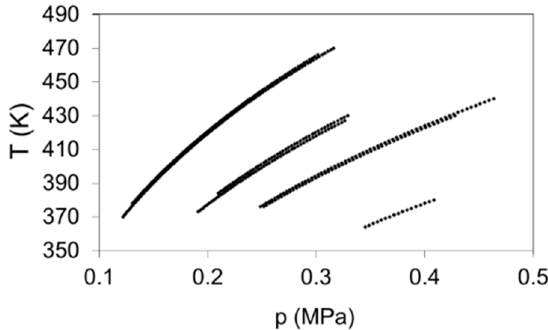
Figure 2. Pressure–temperature lines of adiabatic compression of iso-octane used for the calculation of the burning velocity for stoichiometric conditions.